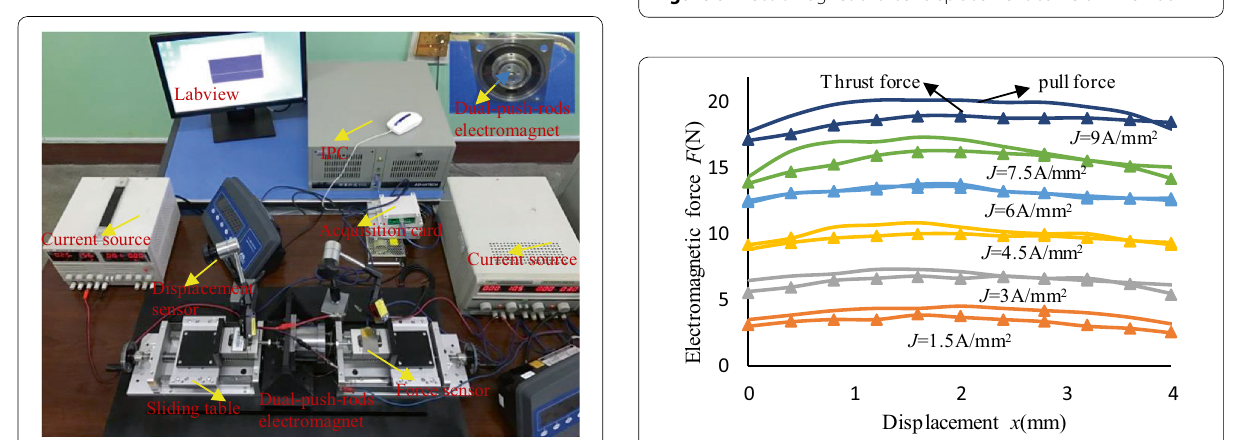
Figure 8 Electromagnetic force–displacement curve of inner rod